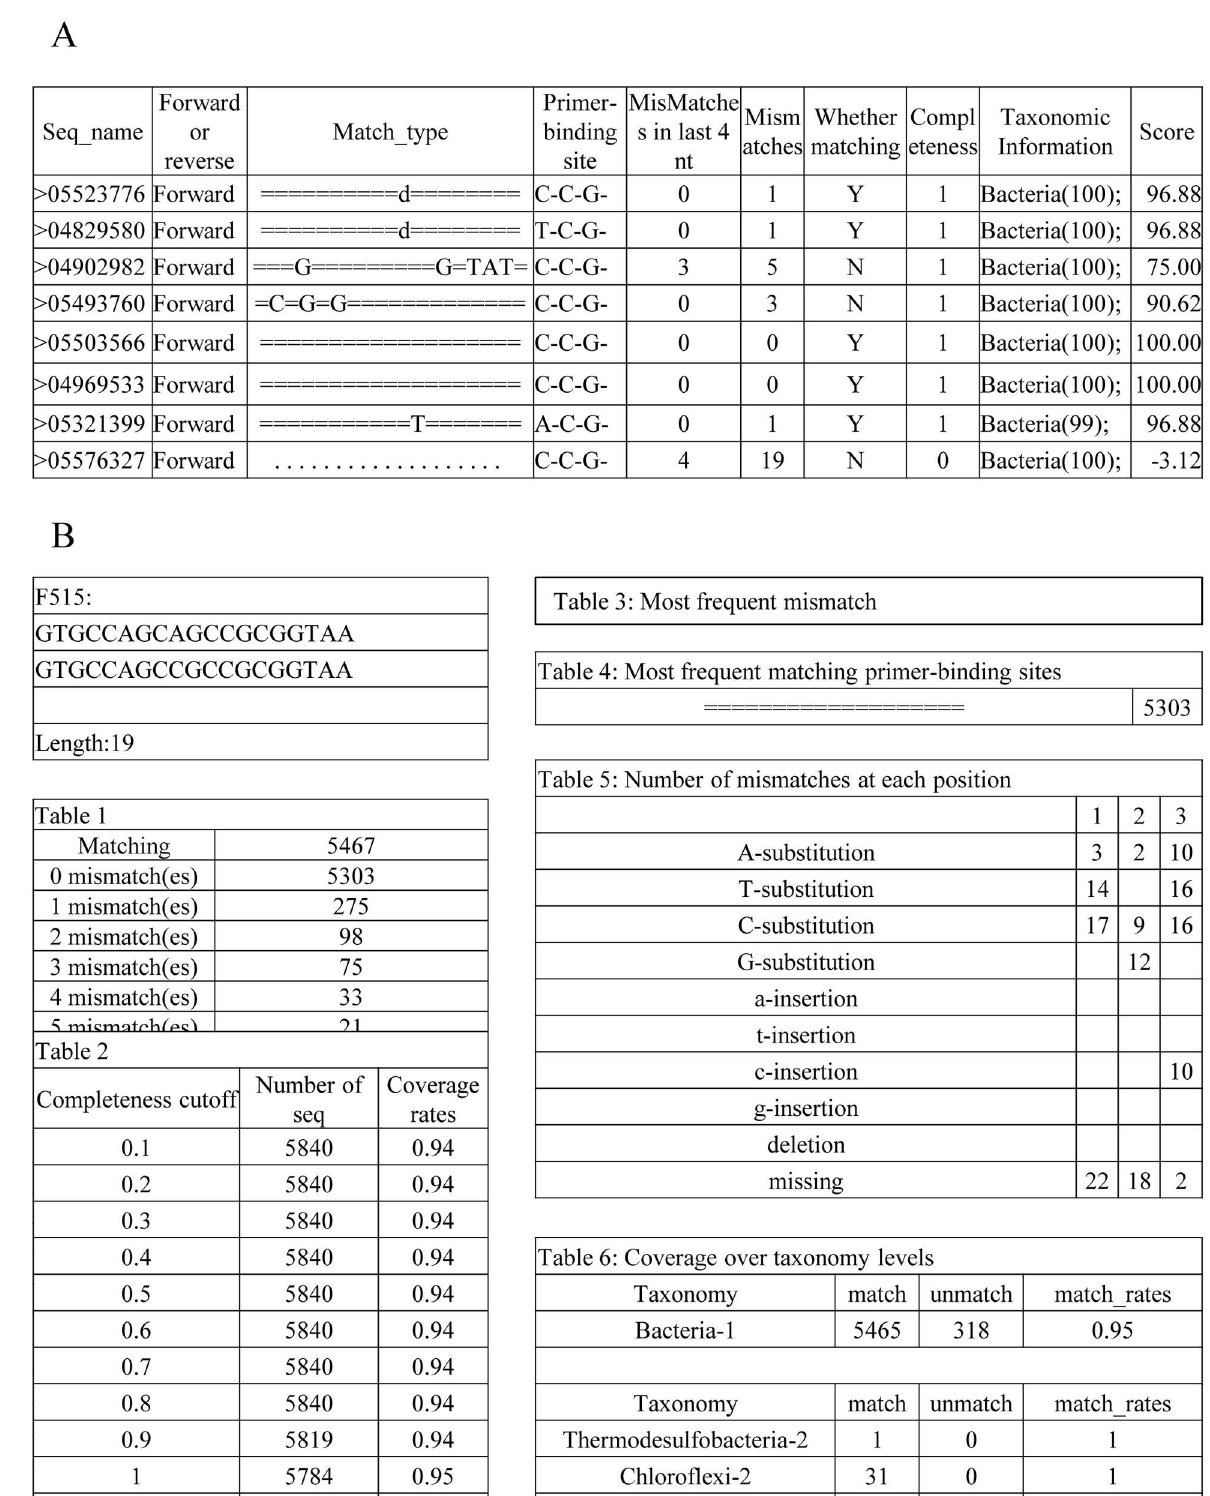
Fig 2. Format of MIPE output. (A) Match type file, “.Match_type”. The file containseach match type for the sequence,the sequence bindingsites for the primers, the mismatch base numbers in total, the mismatch base numbers in last 4 bases, the matched degree, the